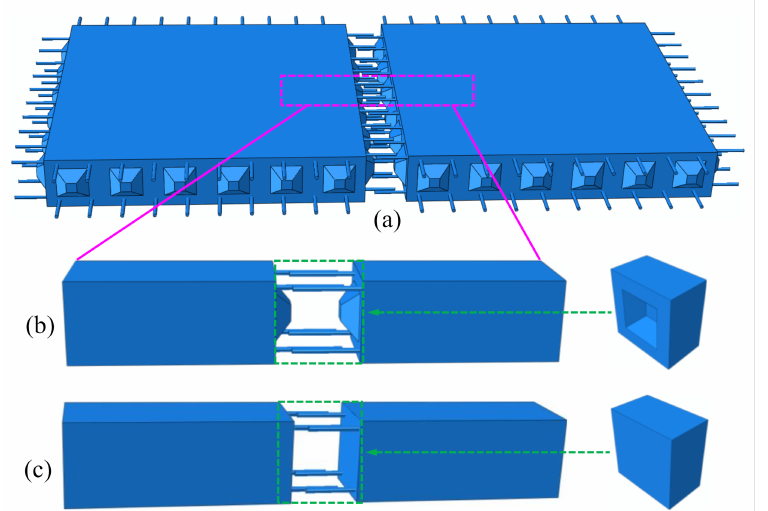
Figure 1. Schematic diagrams of ( a ) bridge panel with convex-shaped shear keys, ( b ) specimen with the concave square frustum-shaped wet joint (S-SWJ) and ( c ) specimen with the conventional wet joint (S-CWJ).